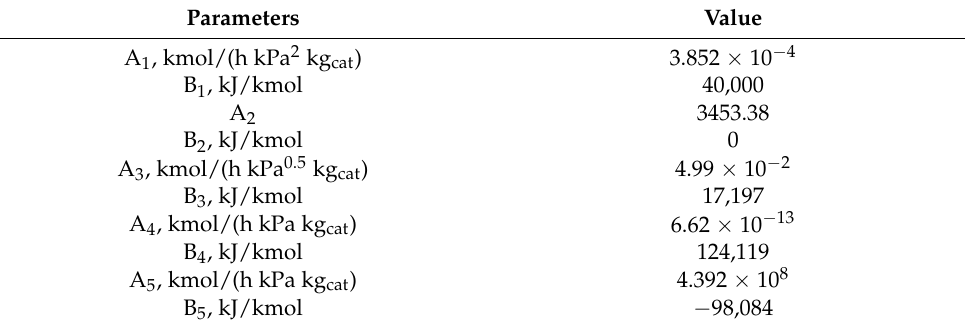
and the small size catalysts of 2 mm, i.e., diffusion limitations are assumed negligible [24]. Table 1. Kinetic parameters for Equations (4)–(8)